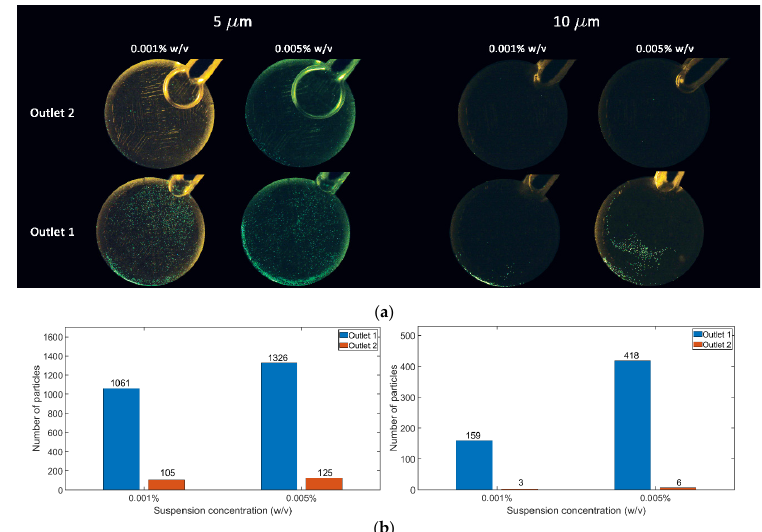
Figure 5. 5 and 10 µm particles focusing results at 0.001% (w/v) and 0.005% (w/v) suspension concentrations. ( a ) Outlet chambers after particle fractionation experiments. ( b ) The effect of particle suspension concentration on focusing efficiency for 5 µm particles (left) and 10 µm particles (right). Results show that higher concentrations return higher throughput while approximately maintaining the same focusing efficiency.